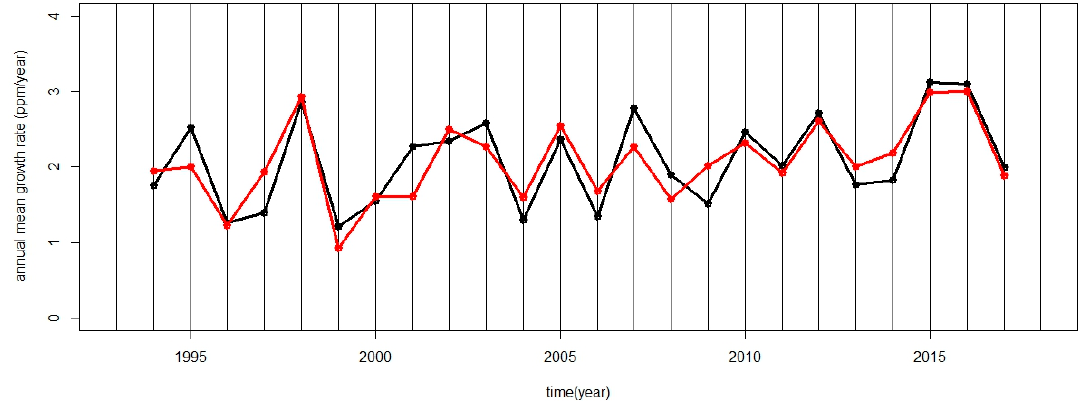
Figure 12. CO 2 annual growth rate at the Plateau Rosa station (black line and points) and at the Mauna Loa station (red line and points) [63].